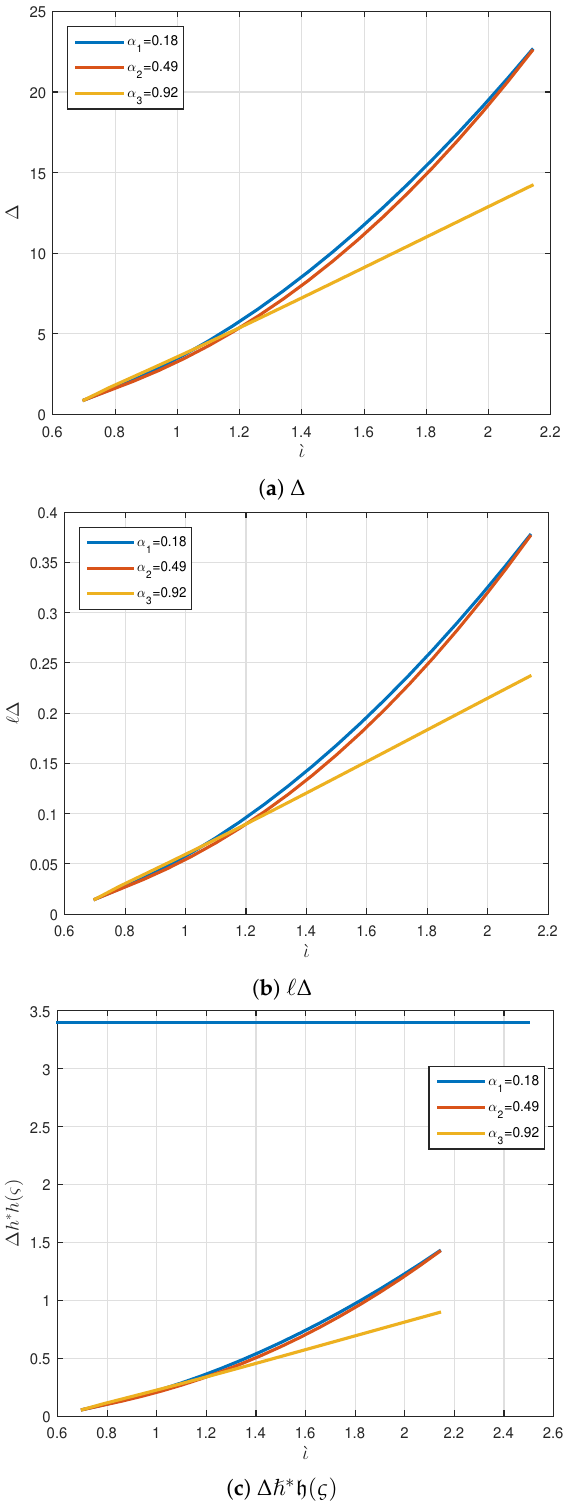
Figure 3. Graphical representation of ∆ , (cid:96) ∆ and ∆ (cid:125) ∗ h ( ς ) for ` ι ∈ [ 0.7,2.1 ] in Example